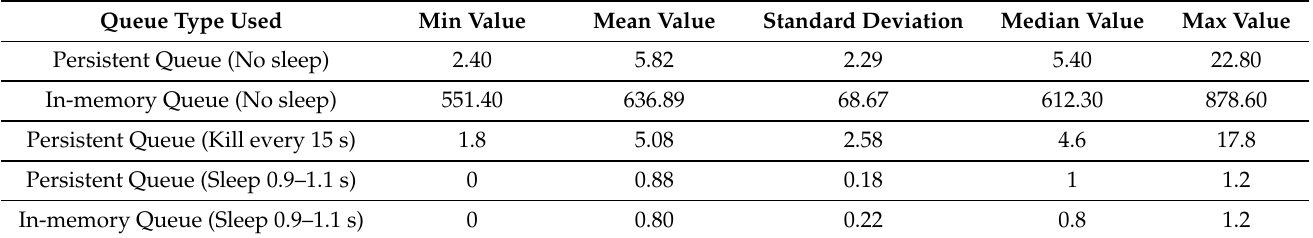
Table 2. A summary derived from the continuous performance experiments explained previously. The table contains the minimum, maximum, mean, median, and standard deviation of all requests per second measured for each